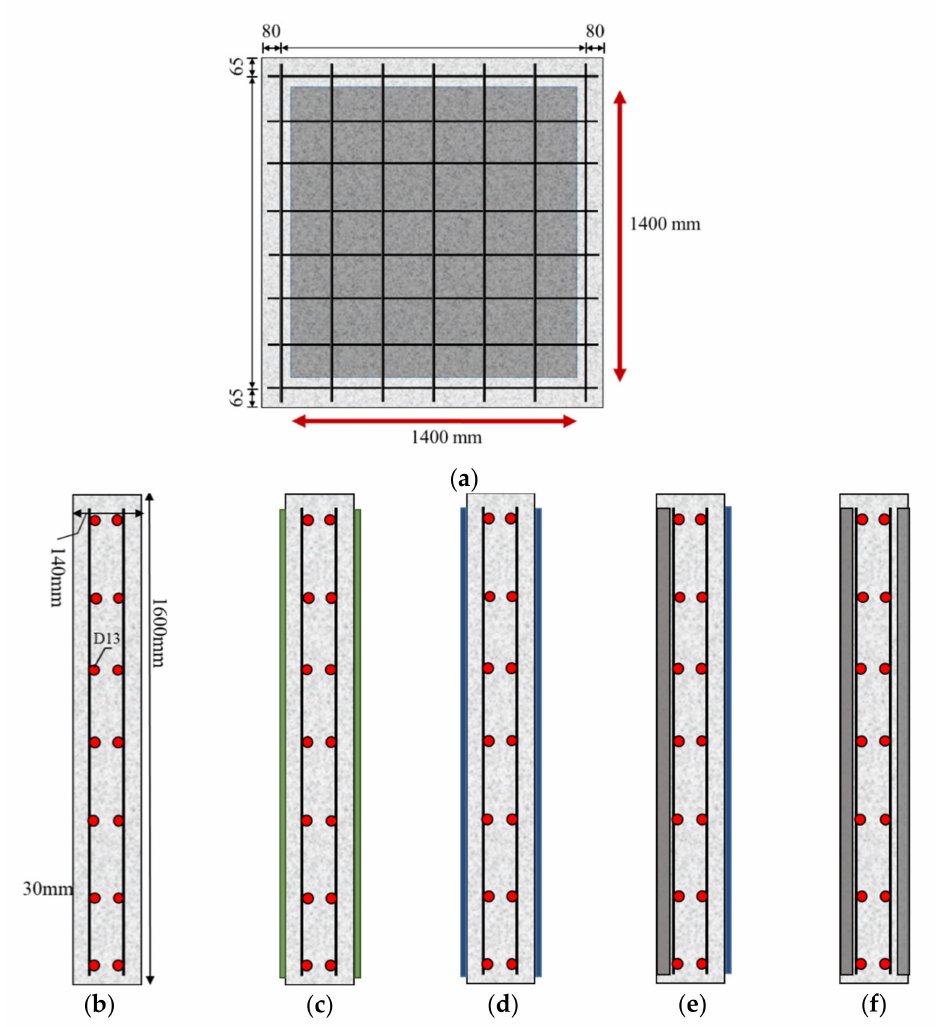
Figure 1. Dimensions and layout of test specimens: ( a ) Dimension of the test specimen; ( b ) NC-NF; ( c ) NC-F; ( d ) NC-F-S; ( e ) NSC-F-S; ( f )